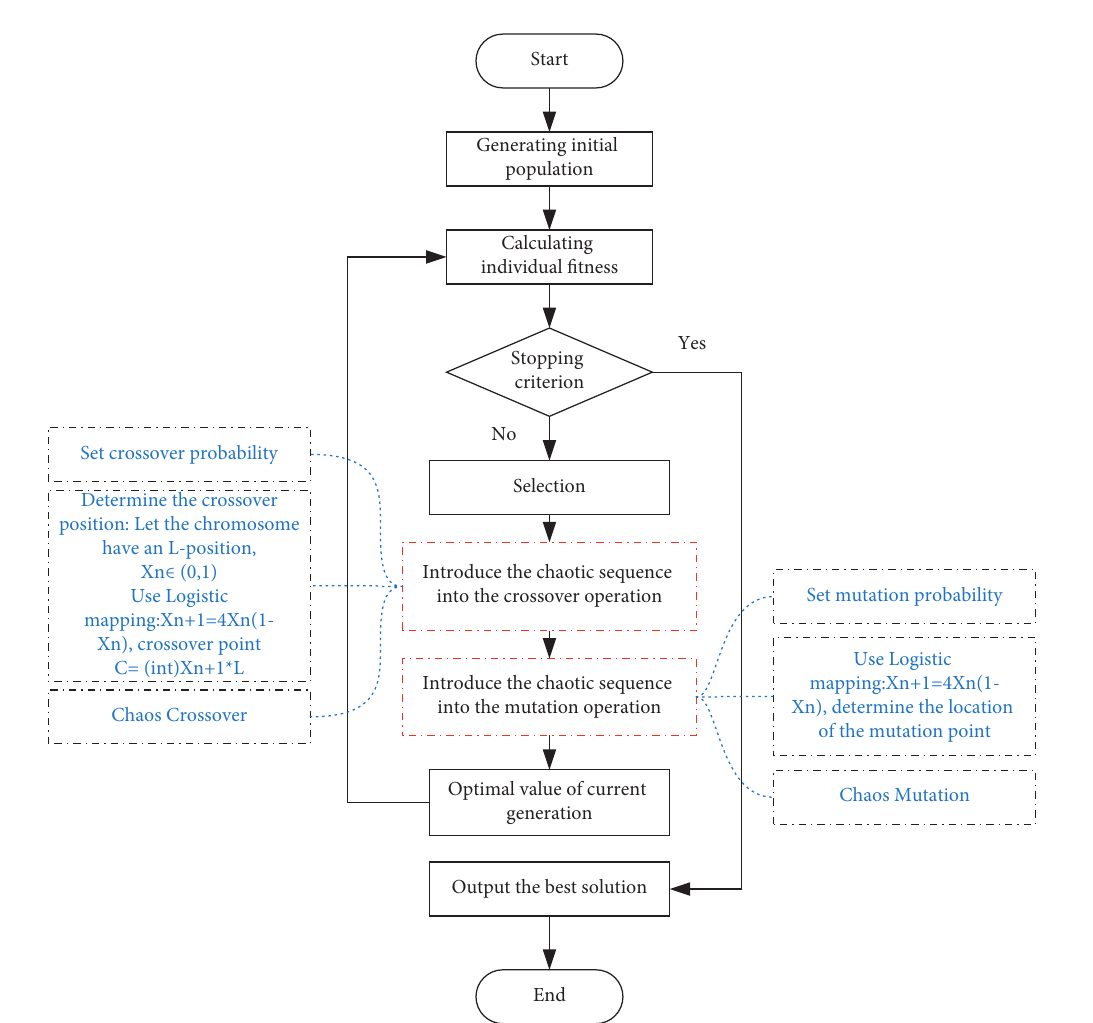
Figure 6: Implementation procedure of the chaotic genetic algorithm based on logistic